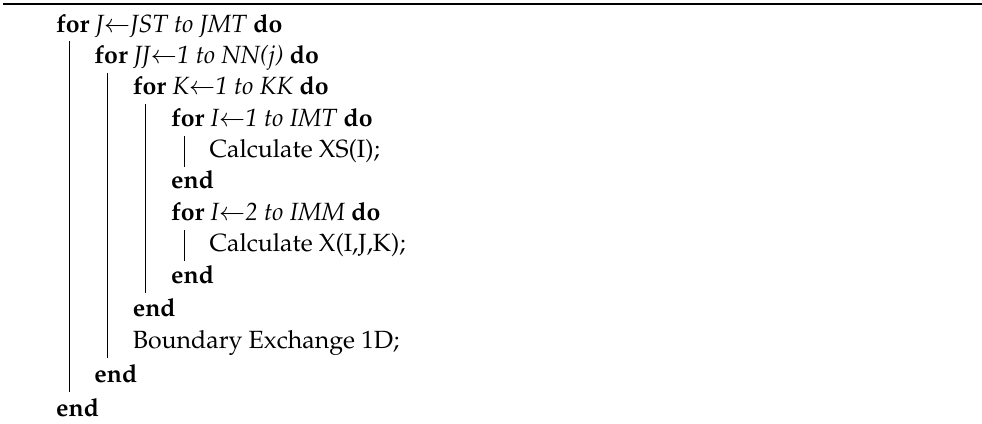
Figure 4. Optimization of the parallelization scheme. Algorithm 2: Communication Optimization